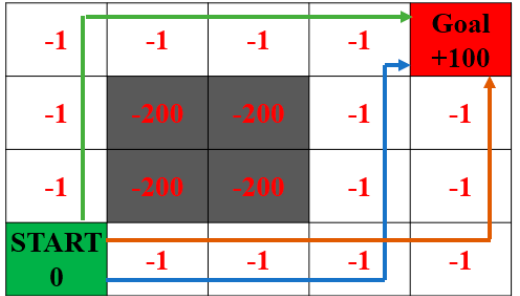
Figure 12. The routes in the reward and punishment rules.